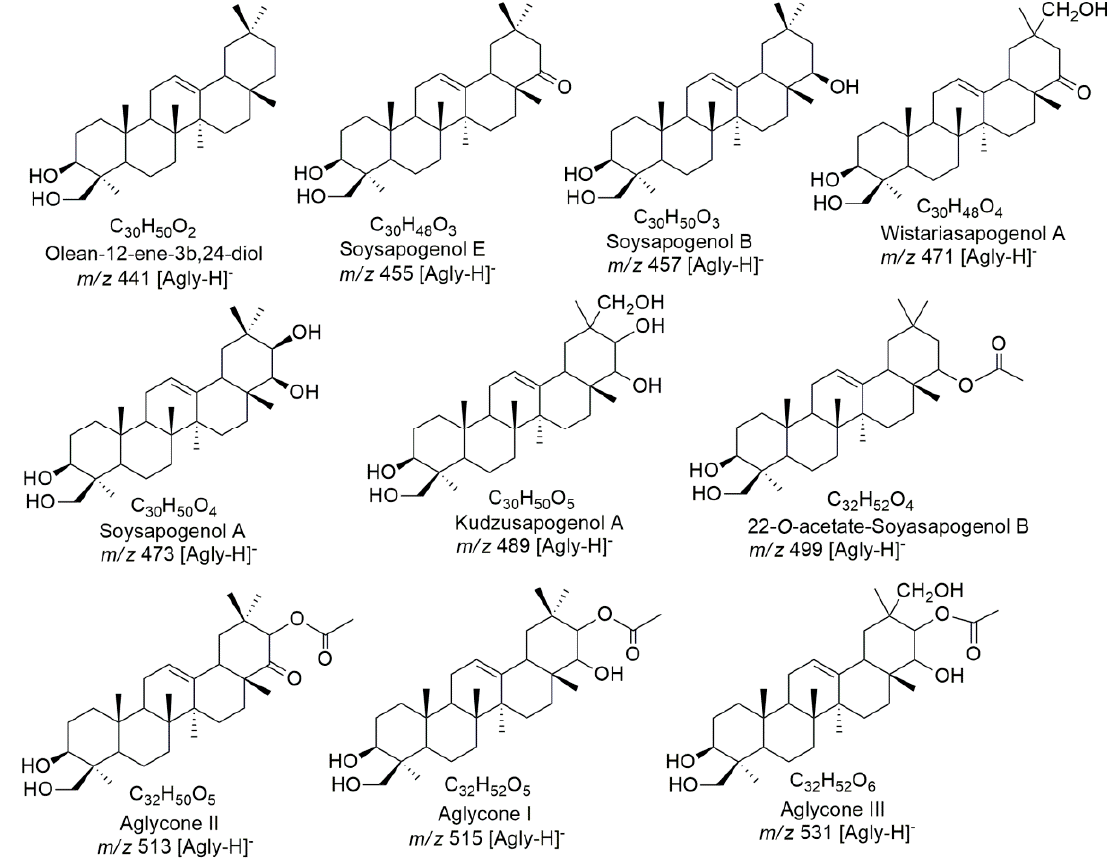
Figure 2. Aglycones of Z. brasiliensis saponins tentatively identified by mass spectrometry.